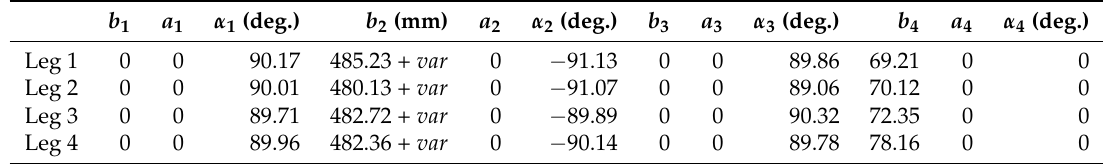
Table 4. Identified DH parameters of each leg.